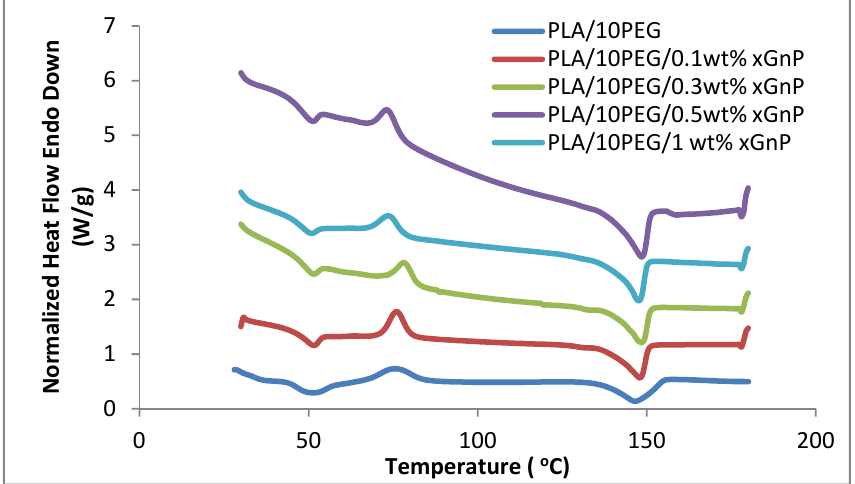
Figure 6. Differential scanning calorimetry (DSC) thermograms of PLA/PEG at various xGnP contents.